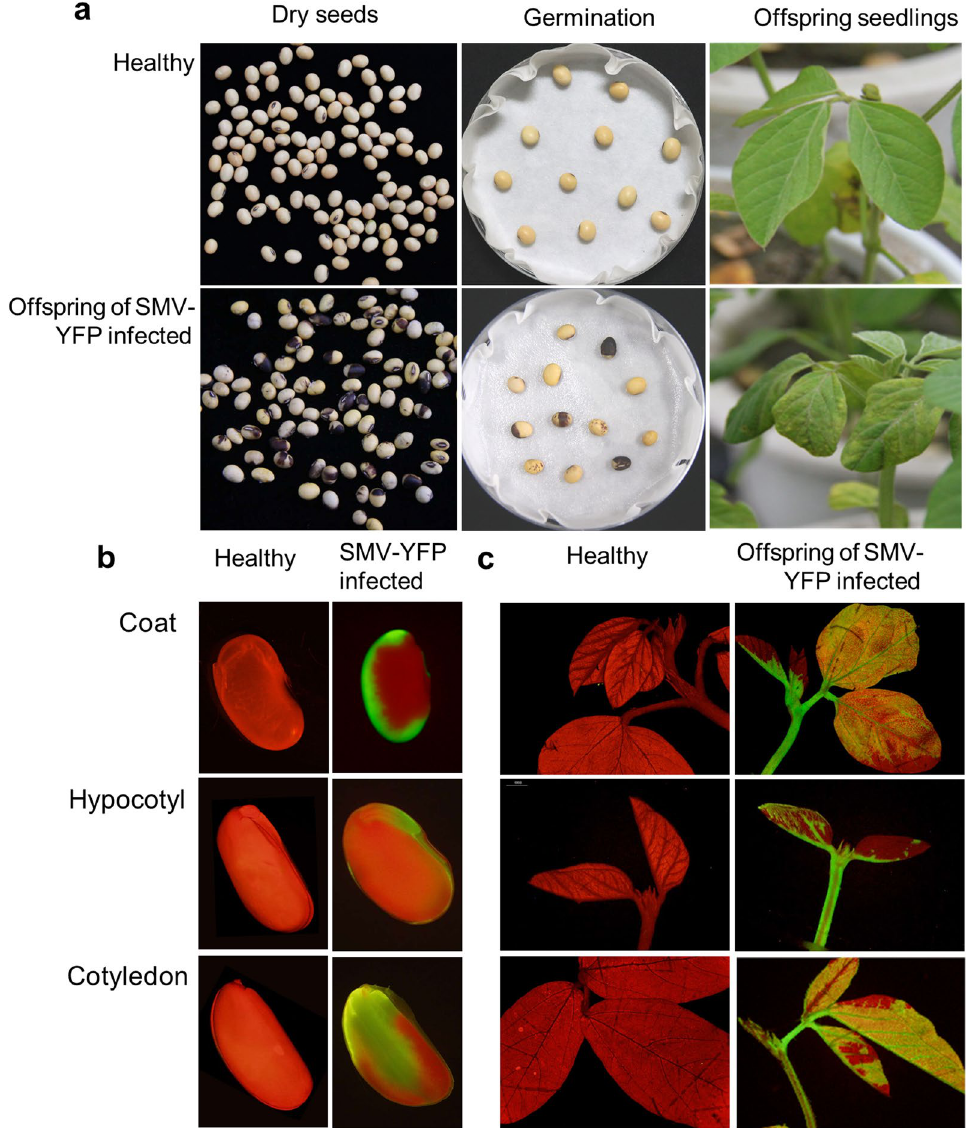
Fig. 5 Phenotypes of offspring plants infected with SMV. a Phenotypes of dry seeds, germinated seeds, and offspring seedlings derived from healthy soybean plants and SMV-YFP infected soybean plants. b The presence of the yellow fluorescence in the seed coat, the hypocotyl, and the cotyledon of the seeds collected from SMV-YFP infected NN1138-2 soybean plants. c SMV-YFP infection could be detected in the offspring plants grown from the SMV-YFP positive seeds (right), but not from virus-free seeds from the healthy plants (left)